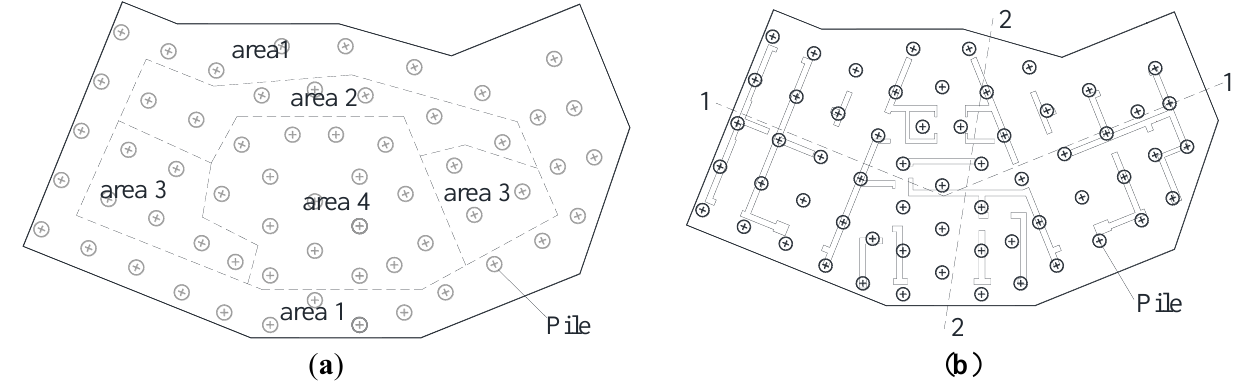
Figure 7. Numerical analysis scheme: deformation adjustors in different regions ( a ), direction of the path ( b ) . Table 3. Different stiffness of deformation adjustors.